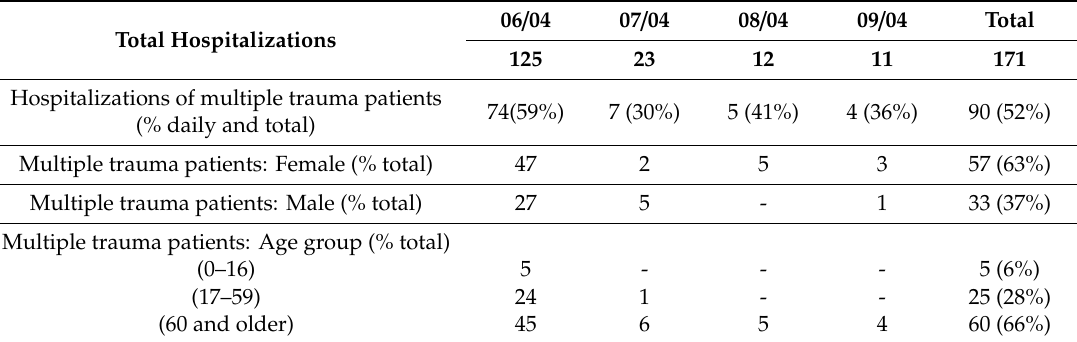
Table 7. Multiple trauma patients by day of admission, age group and gender.